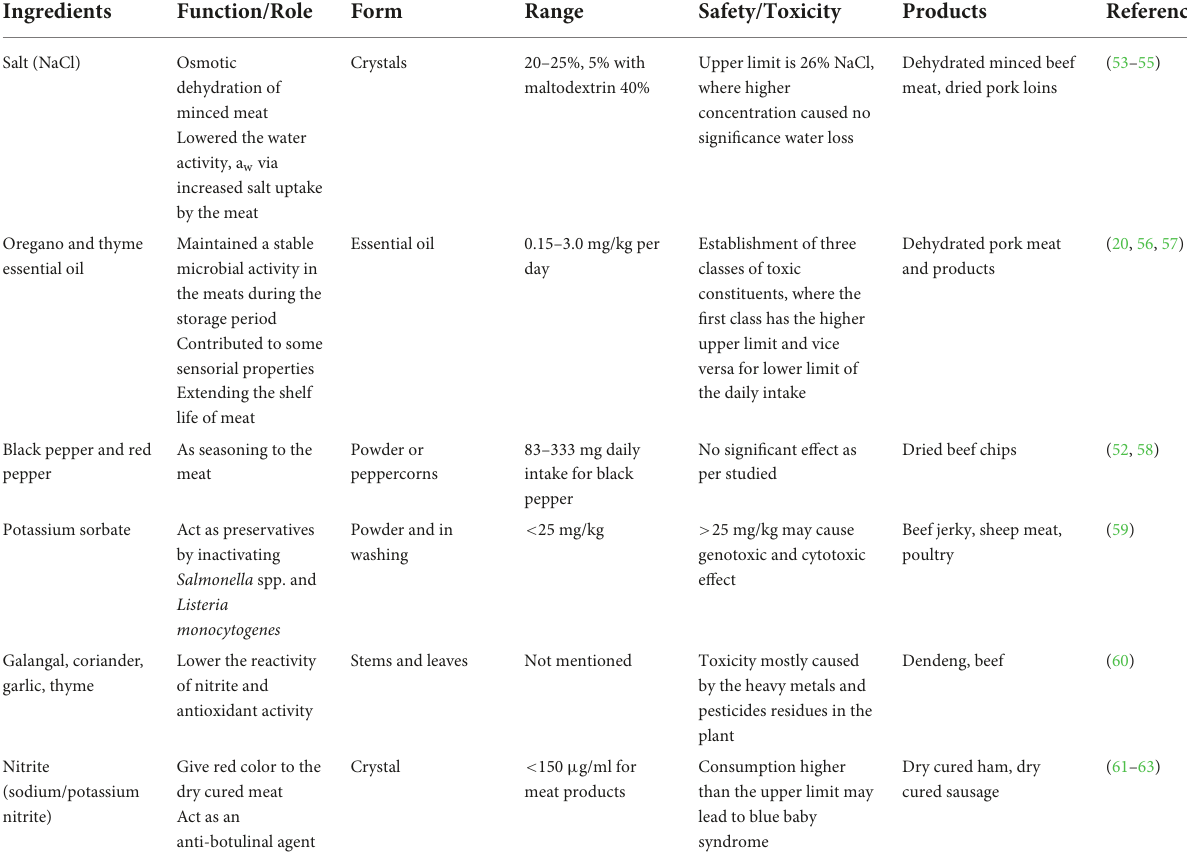
TABLE 3 Non-meat ingredients added during the dried meat